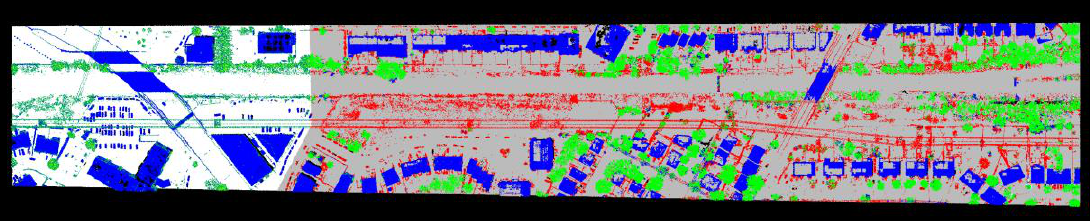
Figure 7. Datasets for training (left) and testing (right)